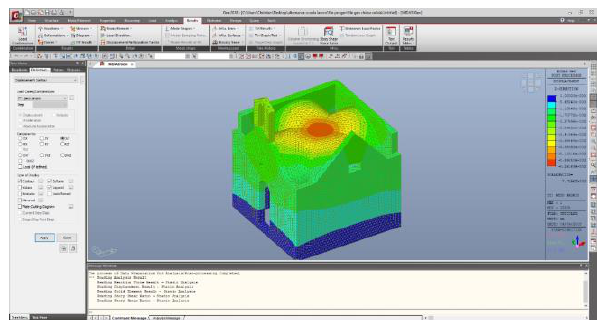
Figure 13. Deformation